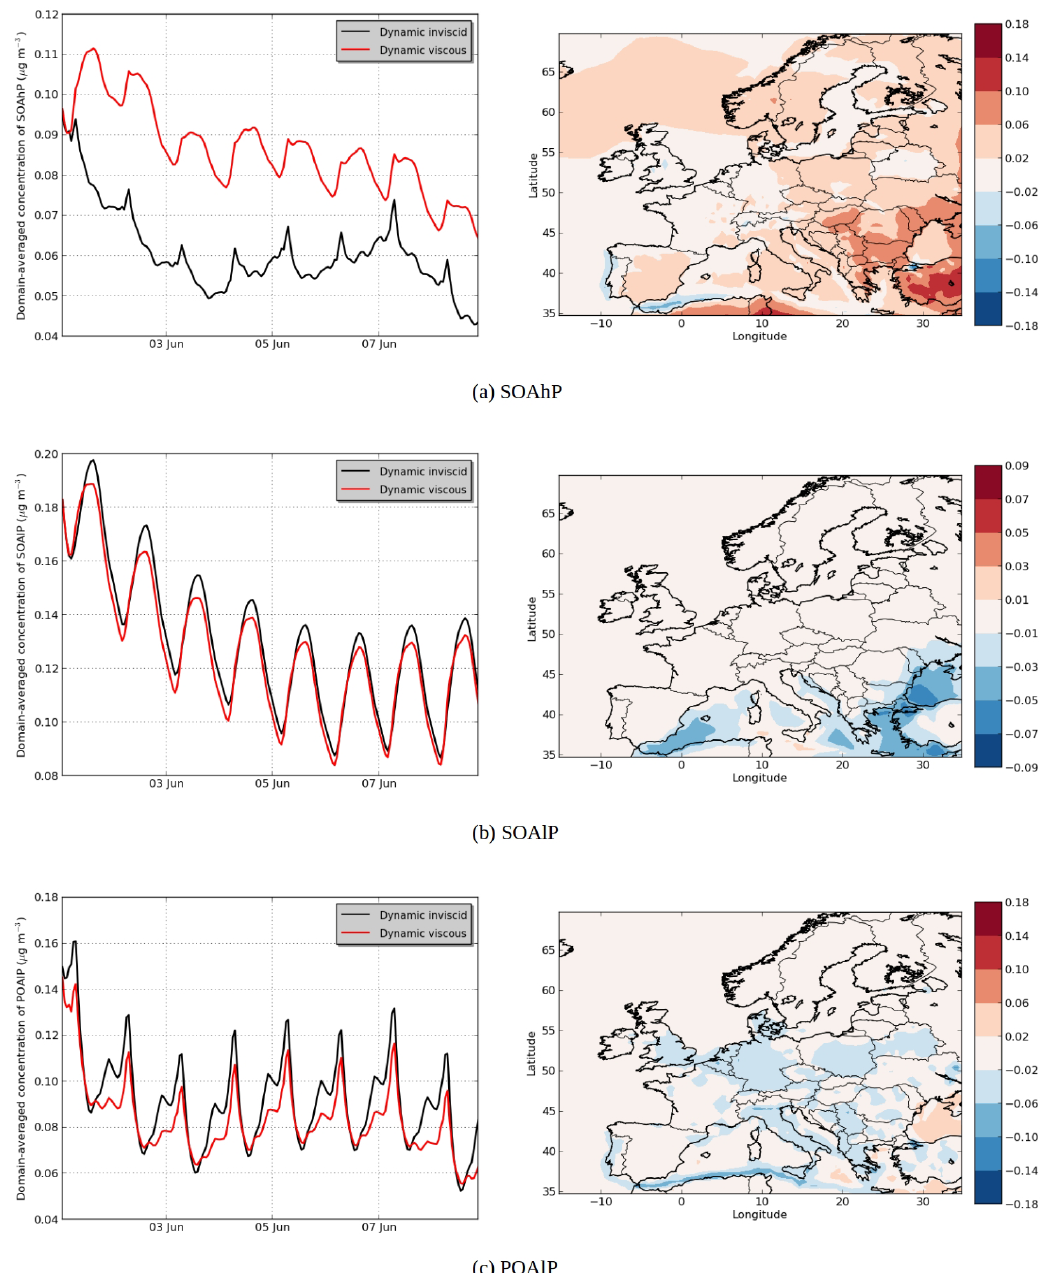
Figure 10. Temporal evolution (left) and differences between the “Dynamic viscous” and “Dynamic inviscid” simulations (right) of modeled SOA concentrations for (a) SOAhP, (b) SOAlP and (c) POAlP (µgm − 3